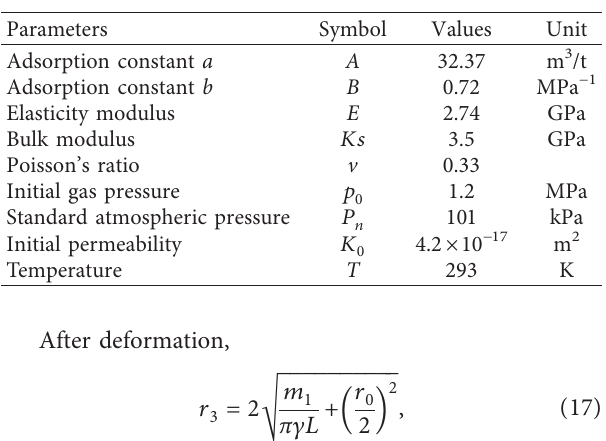
Table 3: Main model